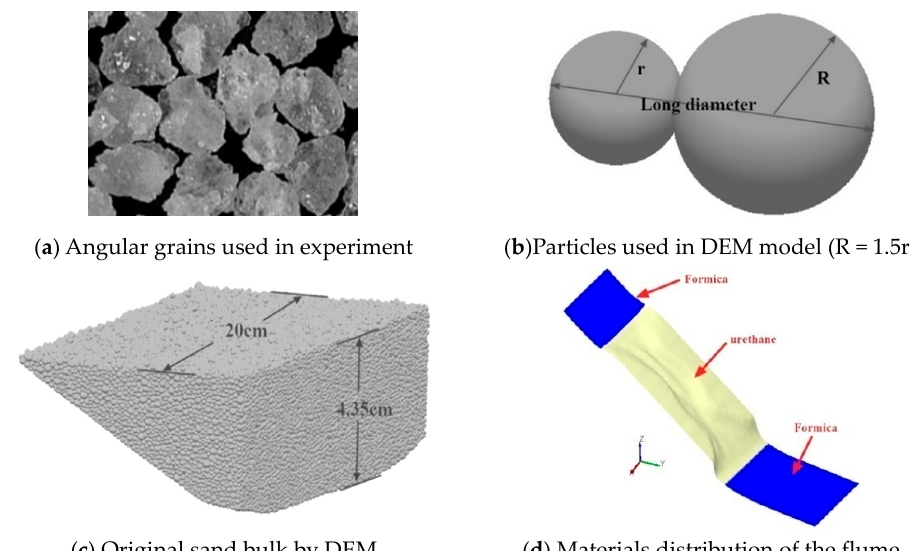
Figure 4. Photographs of particles and devices used in experiment. ( a ) Presents the photomicrographs of particles of the experiment with a diameter between 0.5 – 1mm; ( b ) shows the geometry of a single particle in DEM model; ( c ) depicts the size of origin sand bulk with a volume of 308 cm 3 by DEM; and ( d ) indicates 2 materials distribution of the experiment, which including Formica lines at the up and down of the flume, yet the middle part of the flume with slope averaging 31.6° was lined with a custom-formed urethane insert that provided an irregular basal topography.